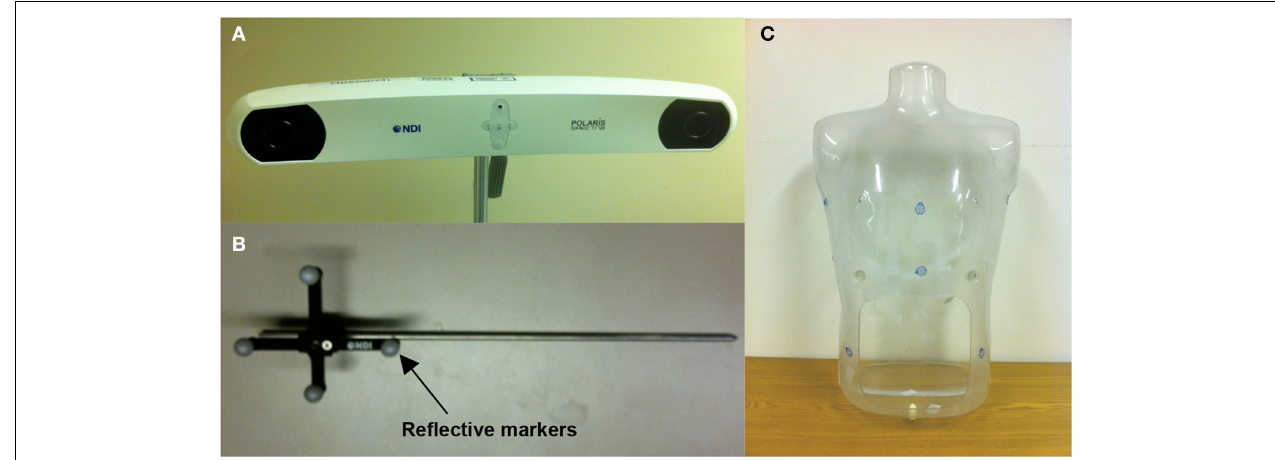
FIGURE 1 | Photographs of (A) pleural PDT navigation camera, (B) tracking tool for the navigation system, and (C) human-shape